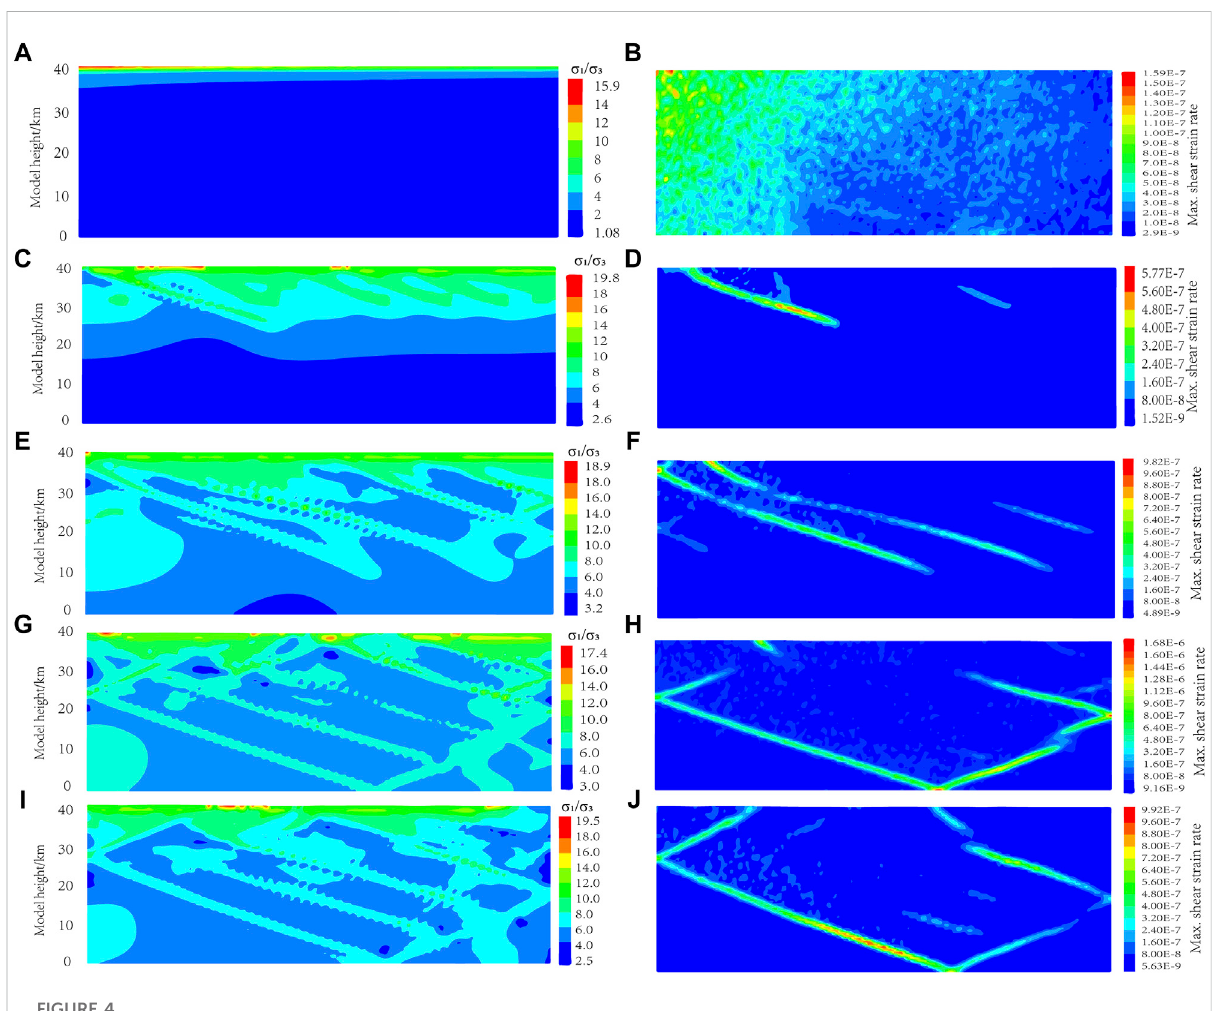
FIGURE 4 Spatial distribution of maximum and minimum principal stress ratio in different periods. The stress ratio and the maximum shear strain (A) (B) when the plate movement acts for 100 k years,the stress ratio and the maximum shear strain (C) (D) when the plate movement acts for 200 k years, thestressratioandthemaximumshearstrain (E)(F) whentheplatemovementactsfor300 k years,thestressratioandthemaximumshearstrain (G) (H) when the plate movement acts for 400 k years, and the stress ratio and the maximum shear strain (I) (J) when the plate movement acts for 500 k